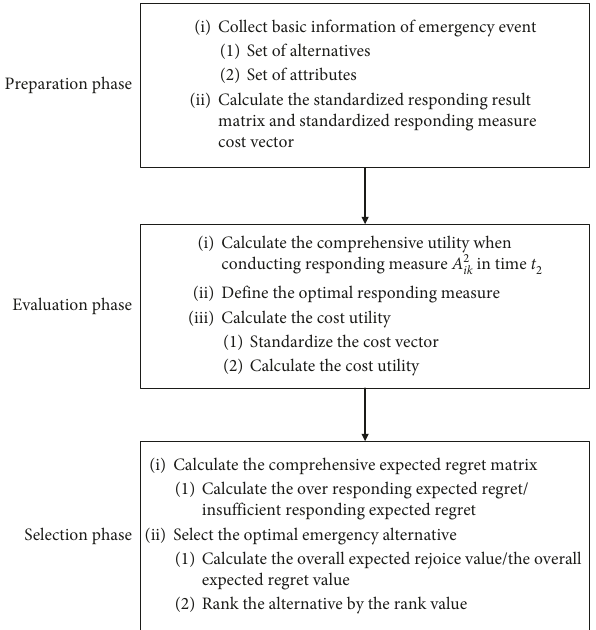
Figure 1: The decision-making process with the proposed